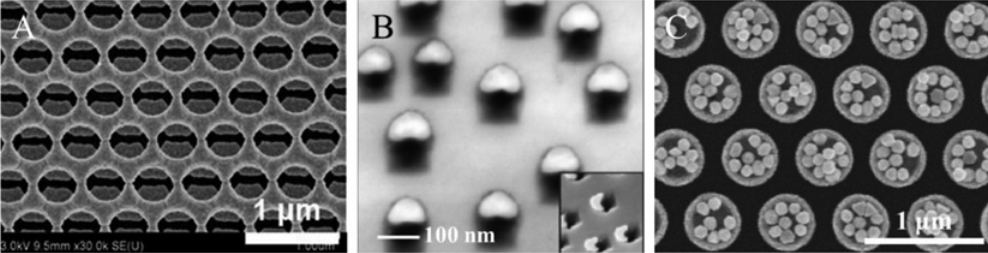
Figure 15: Nanostructures fabricated by using the CL-derived mask. SEM images of (A) opposite metal spindles in nanowells [65], (B) nanopores containing nanocrescent particles [66], and (C) nanoparticle- filled nanodishes